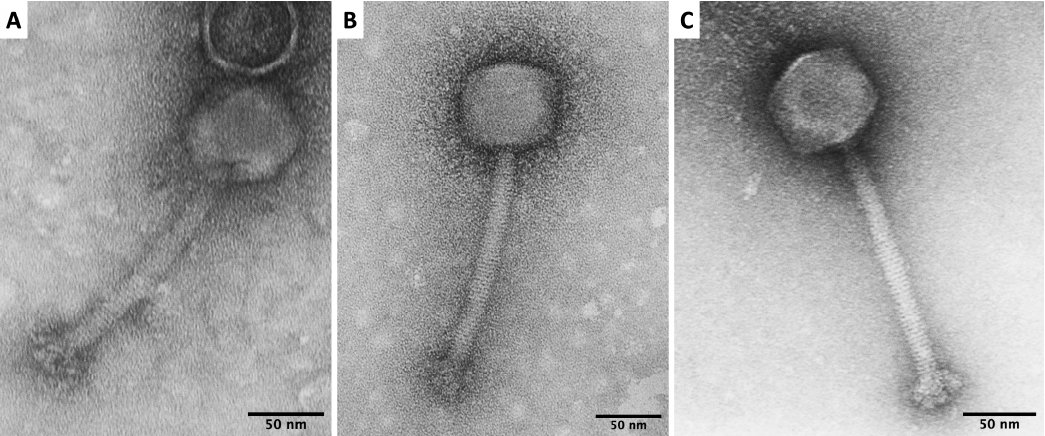
Figure1. Transmissionelectronmicrographs(TEM)ofvB_SauM-A( A ),vB_SauM-C( B ),vB_SauM-D( C